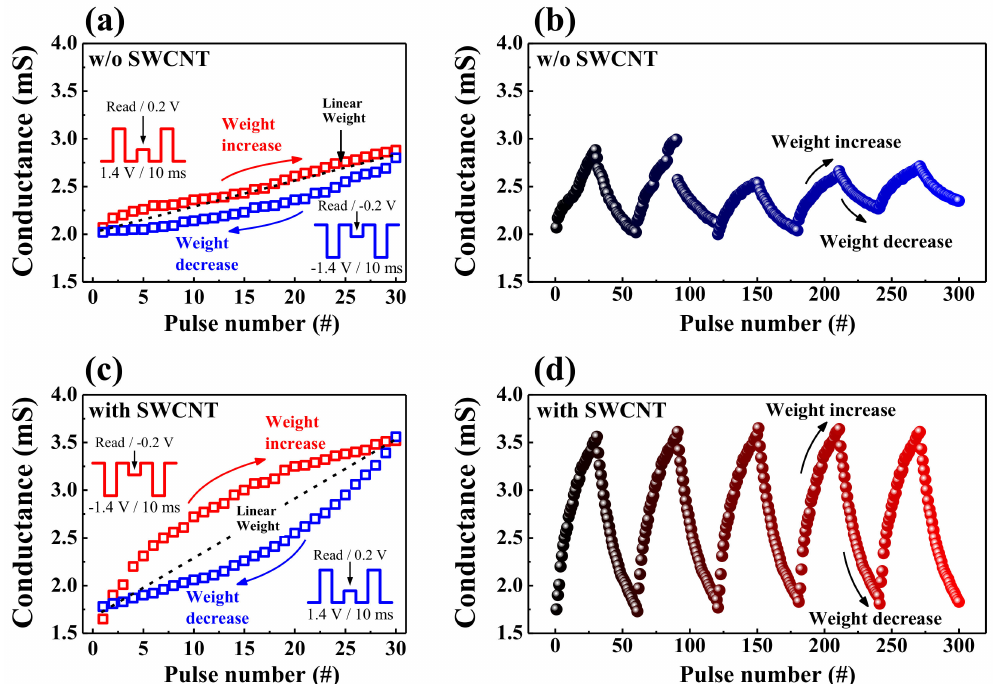
Figure 9. Synaptic weight potentiation/depression for HSQ memristors w/o ( a , b ) and w/ ( c , d ) the embedded SWCNT random network: ( a , c ) one-cycle properties of consecutive conductance modulation (insets depict the synaptic pulse scheme of potentiation, depression, and read operations) and ( b , d ) weight modulation reliability for 3 × 10 2 synaptic